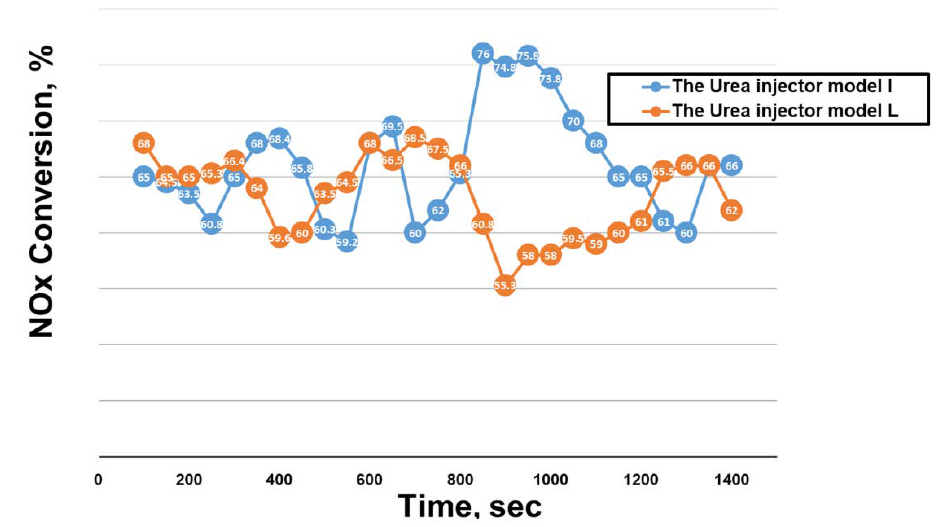
Figure 35. The comparison of NOx conversion between injector model I and model-L (MEXA-7100 gas analyzer), adapted from Khristamto et al.